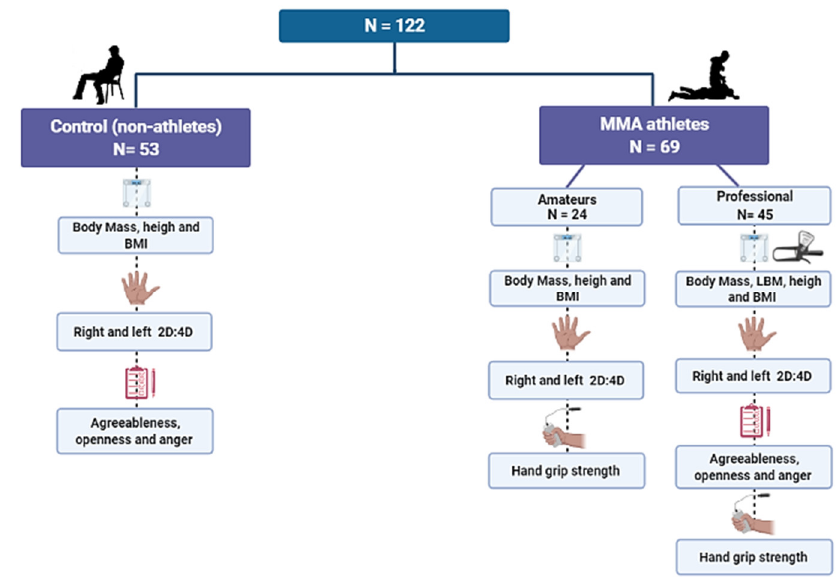
Figure 1. Sample distribution and dependent